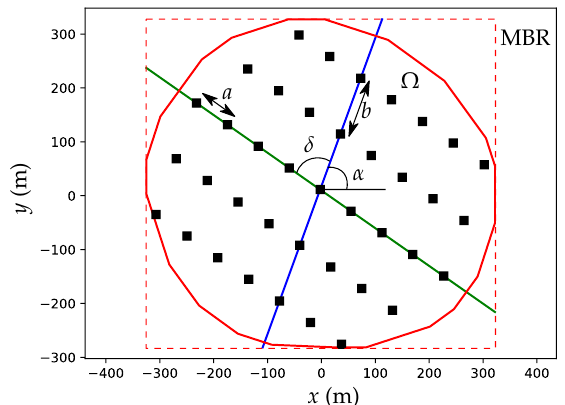
Figure 1. Array layout description. The black dots represent wave energy converter (WEC) positions. The continuous red line is the bounds of the array deployment, the blue line is a row, and the green line is a column. The x -axis is aligned with the main direction of propagation of the ambient